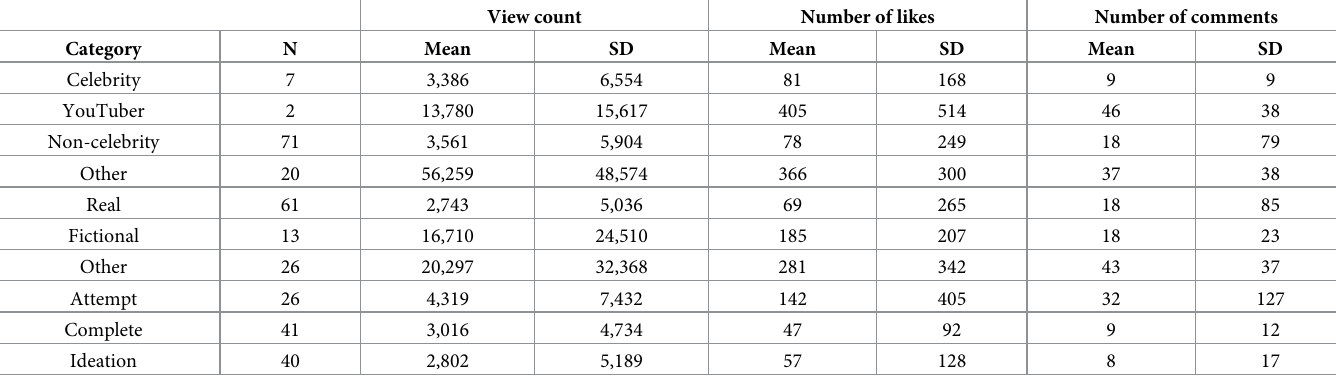
Table 2. Descriptive statistics for story characteristics